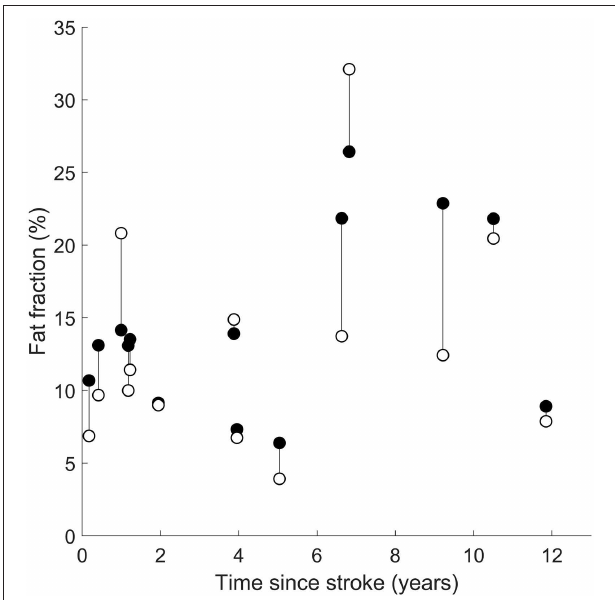
FIGURE 5 | Intramuscular fat fractions in the paretic (filled circles) and non-paretic (open circles) medial gastrocnemius muscles after a stroke. Vertical lines join paretic and non-paretic muscles from individual stroke patients.